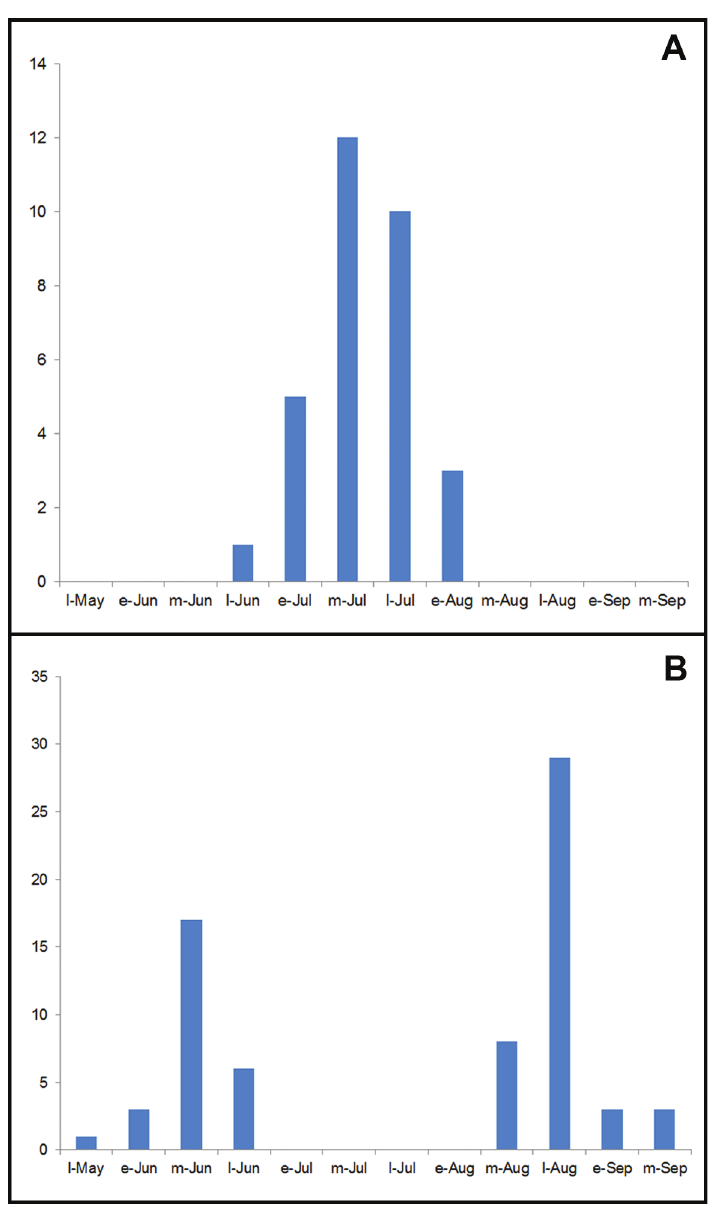
Figure 22. Comparative adult flight times of Clemensia umbrata and C. albata in northeastern North America, based on collection dates by 10-day monthly